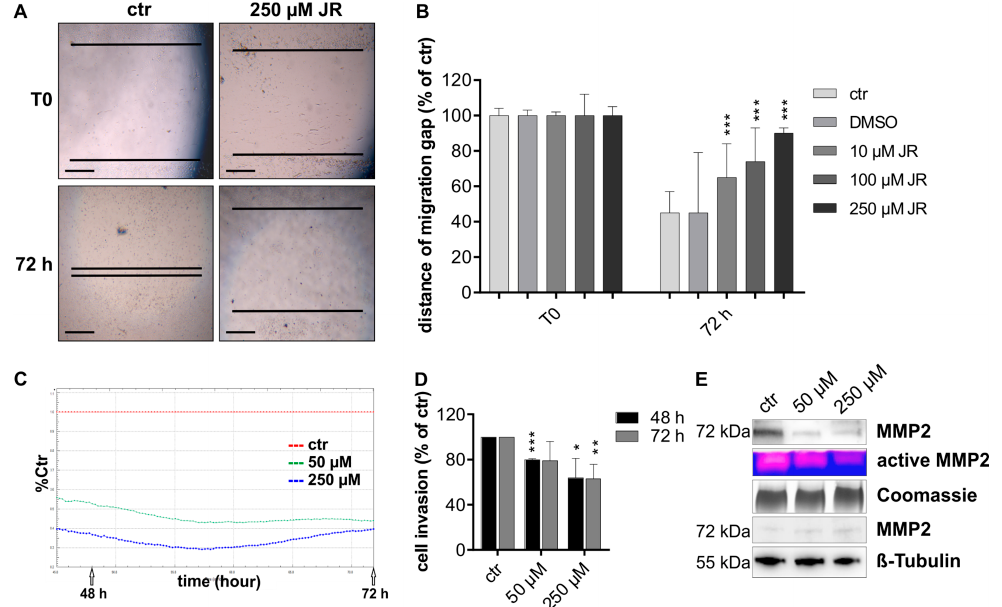
Figure 4. mTORC2 blockade inhibited migration and invasion capacity by regulation of MMP2. Migration capacity of MelJu was investigated after exposure of 10–250 µM JR-AB2-011 by wound closure assay over 72 h. Representative images ( A ) show the initial gap (T0) and the gap after 72 h of control and treatment with 250 µM JR-AB2-011. The initial width of the migration gap was 2 mm and is shown as the distance of the migration gap. Scale bar indicates 500 µm. ( B ) Treated cells were normalized to T0 (start of the experiment) set to 100% (±SD of three independent experiments). Asterisks (* p ≤ 0.05, ** p ≤ 0.01, *** p ≤ 0.001) indicate significance (10µM p = 0.000017; 100µM p = 0.000004; 250µM p = 0.000001) between treatment and the control (72 h). Real-time invasion of MelJuSo ( C ) was investigated with RTCA measurement over 72 h after exposure to JR-AB2-011 (50–250 µM). Arrows indicate the time points of 48 h and 72 h. The red line shows untreated control set to 100% compared to treatment with 50 µM (green) and 250 µM (blue). All cells started at the same time point. The treatment with JR-AB2-011 significantly reduced the invasion capacity of MelJuSo after 48 h and 72 h ( D ). Asterisks (* p ≤ 0.05, ** p ≤ 0.01, *** p ≤ 0.001) indicate significance between treatment and the control set to 100%. Representative images ( E ) of Western Blot analysis and zymography analysis with conditioned media of MelJuSo (upper panel) indicate a reduction of expression and activation of MMP2 in melanoma cells, whereas less inactive MMP2 accumulated in the cell lysate (lower panel) when treated with 50–250 µM JR-AB2-011. 4 µg of protein of the supernatant and 20 µg of the cell lysates were screened for MMP2. Coomassie staining of the gel was used as a loading control for conditioned media, β -Tubulin was used as a loading control for cell lysates. Figures are representative for three independent experiments, displayed are cropped blots; for full gels, see Supplementary Data.